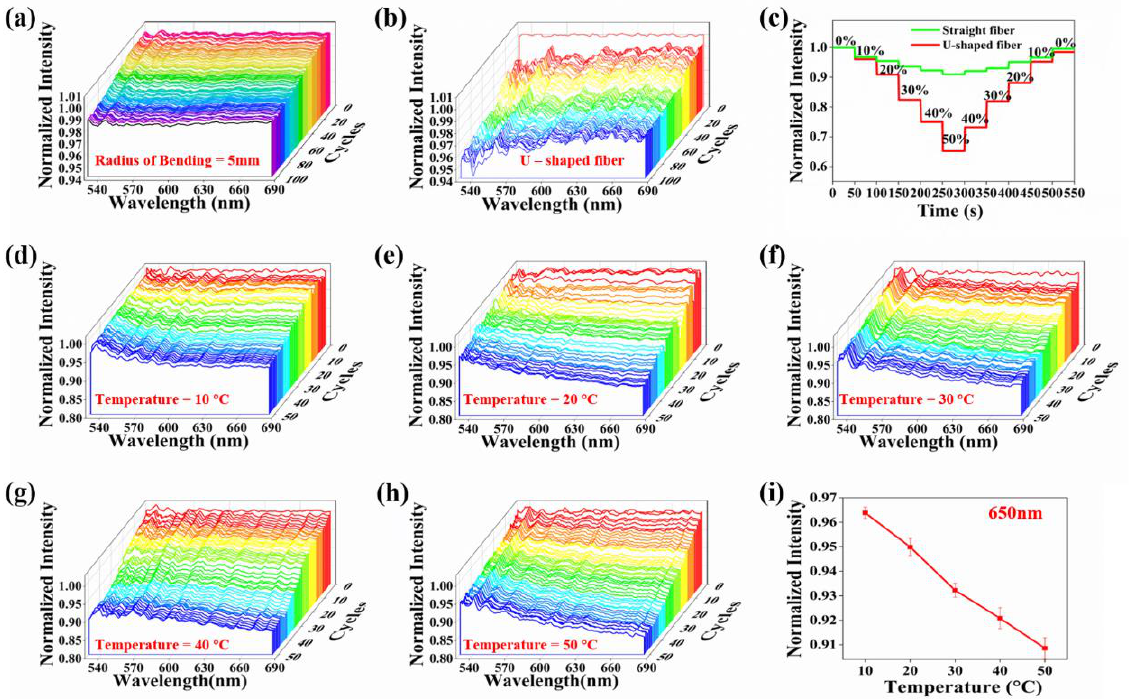
Figure 4. Bending and stretching sensing performance of the elastic fiber. ( a ) The elastic optical fiber is bent 100 cycles with a bending radius of 5 mm. ( b ) Tensile test of the U-shaped elastic fiber being stretched 100 cycles at the strain range 0~50%. ( c ) Comparison of sensing performance between straight and U-shaped elastic fibers during strain increase from 0 to 50% and back to 0. Tensile test of elastic fiber being stretched 50 cycles with 50% applied peak strain at different temperatures, ( d ) 10 °C, ( e ) 20 °C, (f) 30 °C, ( g ) 40 °C, ( h ) 50 °C. ( i ) The average normalized light intensity curve at 650 nm for five temperatures.